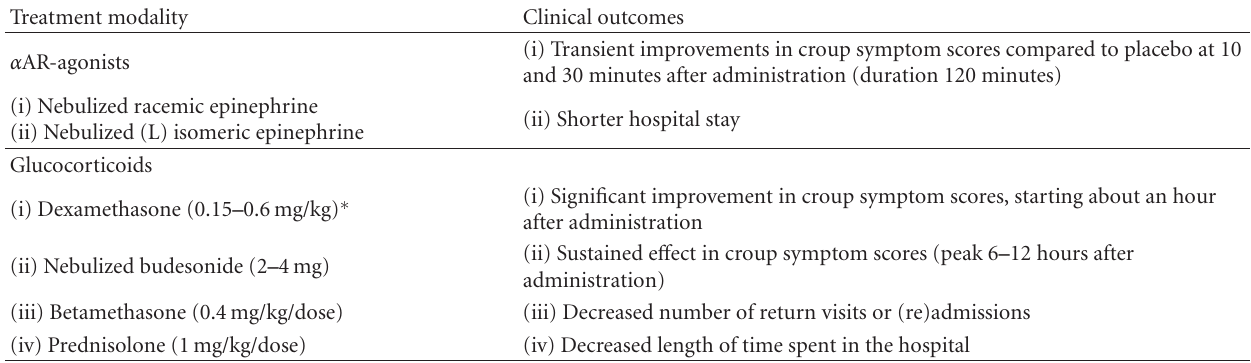
Table 3: Clinical e ff ects of α AR-agonists and glucocorticoids in viral-induced